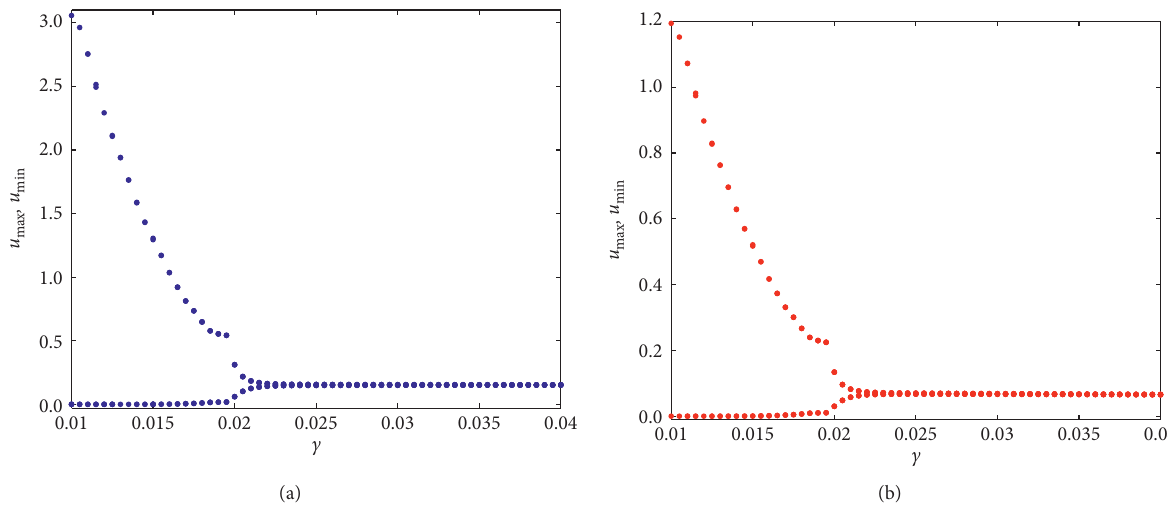
Figure 11: Bifurcation diagram with respect to intraspecific competition between prey species c for predator-prey system (19) with Beddington–DeAngelis response function. Rest of parameters are specified as r ξ � 0 .